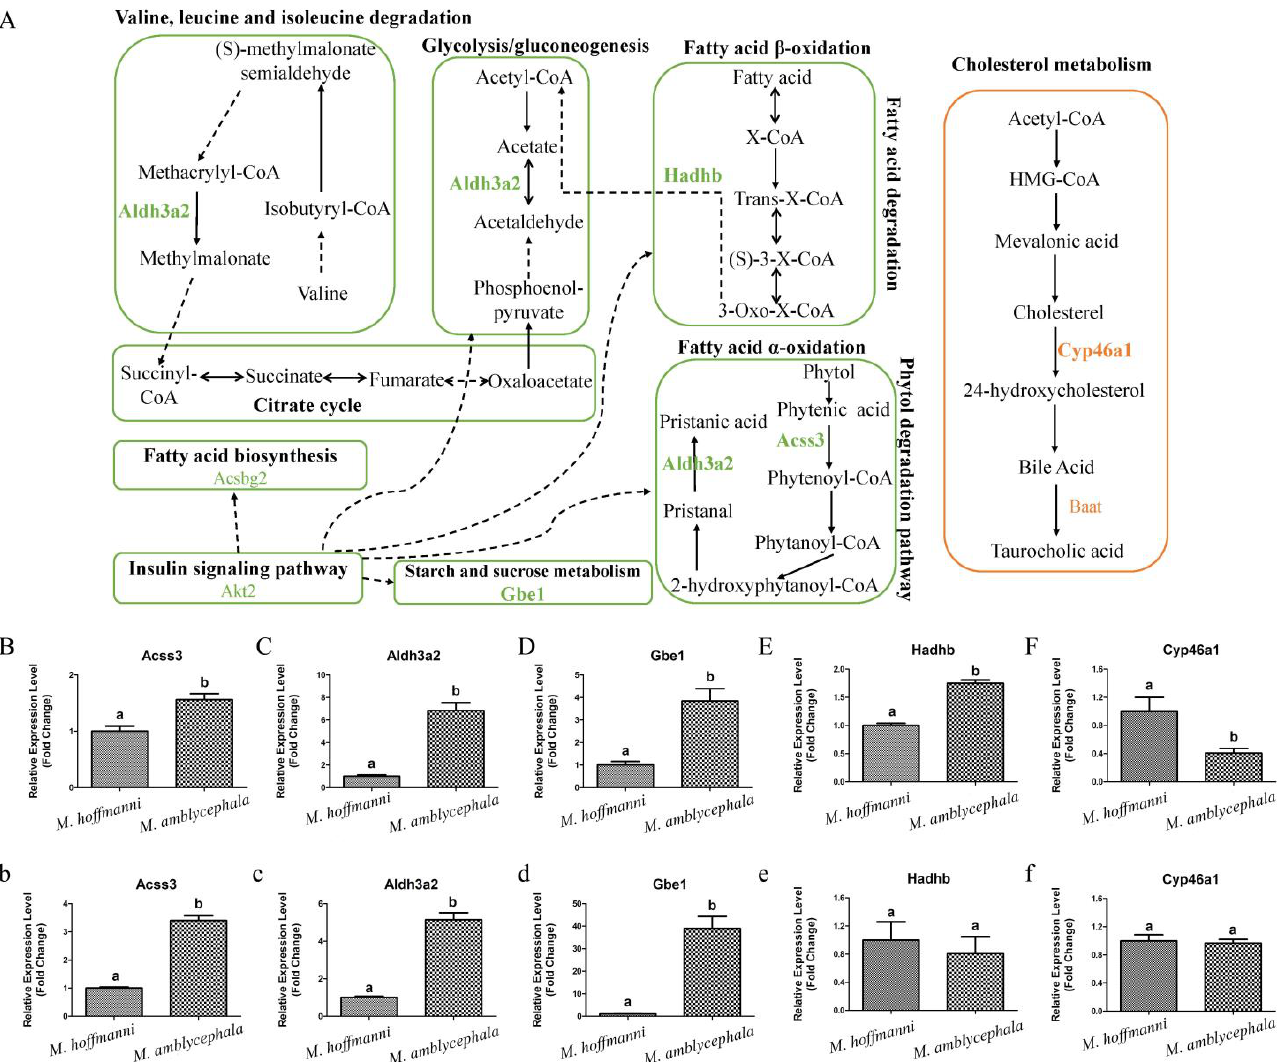
Figure 6. Metabolism pathways and expression pattern of candidate genes. ( A ) Candidate genes of M. amblycephala and M. hoffmanni enriched in the metabolism pathways. The lines and selected genes in M. amblycephala and M. hoffmanni are indicated in green and pink, respectively. The dashed lines used to connect KEGG pathways represent indirect relationships. ( B – F ) The expression pattern of candidate genes ( Acss3 , Aldh3a2 , Gbe1 , Hadhb , and Cyp46a1 ) in the liver tissue of M. amblycephala and M. hoffmanni . ( b – f ) The expression pattern of candidate genes ( Acss3 , Aldh3a2 , Gbe1 , Hadhb , and Cyp46a1 ) in the spleen tissue of M. amblycephala and M. hoffmanni . Different letters indicate a significant difference ( p < 0.05).